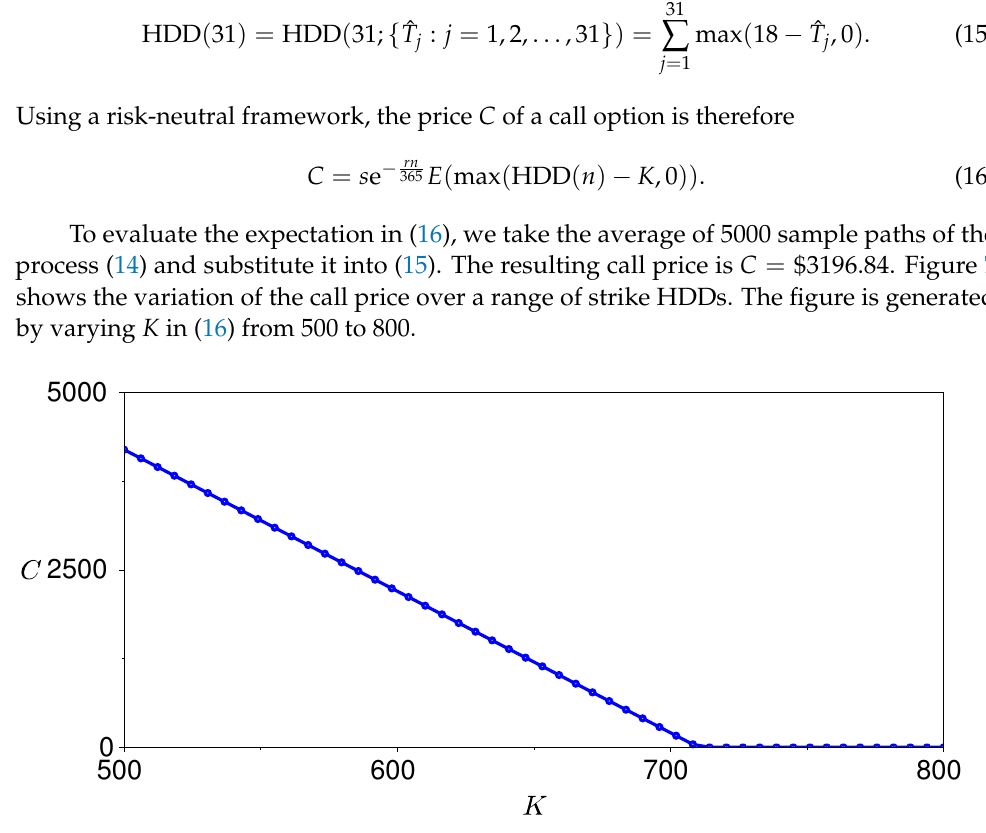
Figure 7. Variation of the call price with respect to the strike